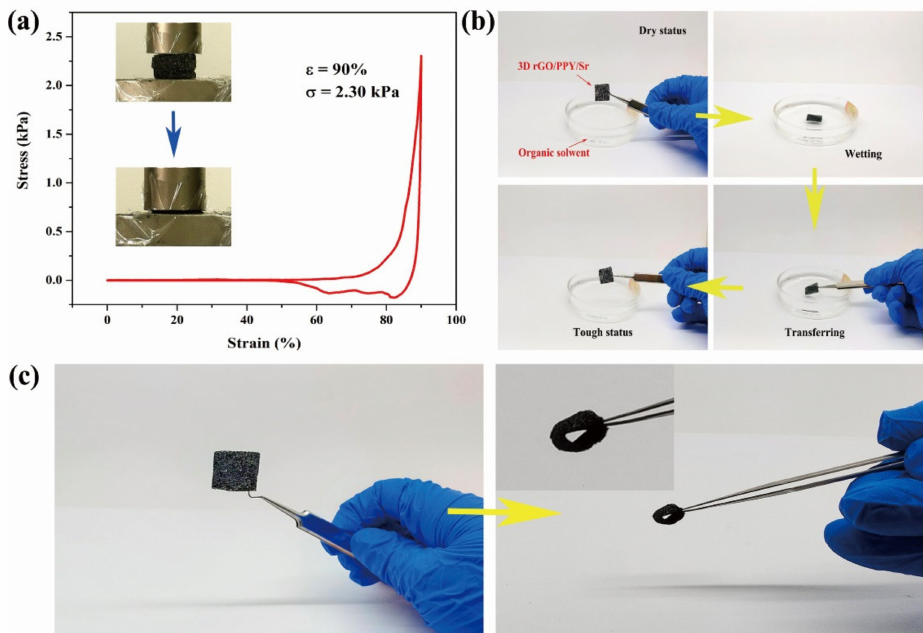
Figure 7. ( a ) Comparative mechanical compression test of 3D rGO/PPY/Sr scaffold with a maximum strain of up to 90%. Insets are the snapshots during compression. ( b ) Validation of mechanical robustness of 3D rGO/PPY/Sr scaffold during operation in solvent conditions. ( c ) Optical image of prepared 3D rGO/PPY/Sr scaffold with O-ring.